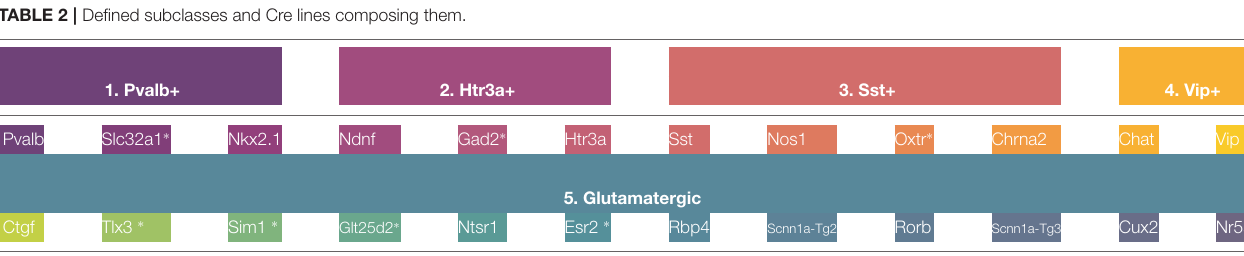
TABLE 2 | Defined subclasses and Cre lines composing